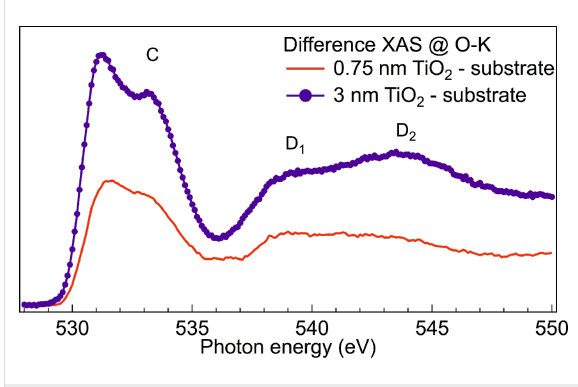
Figure 3: XAS difference spectra. The contribution of SiO 2 to the XAS at the O-K edge was subtracted from the measured spectra. Feature D of Figure 2 is now described by two features: D 1 and D 2